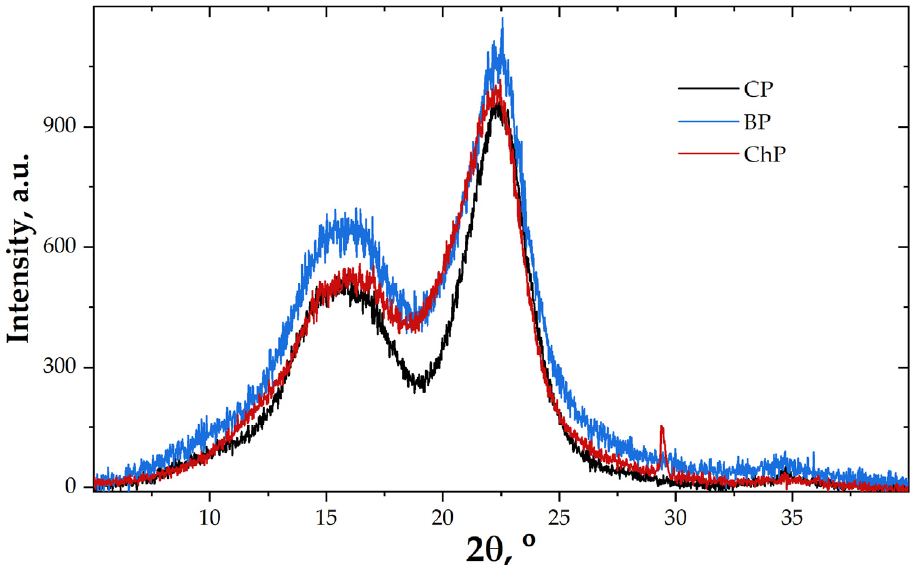
Figure 4. X-ray diffractograms of pine wood samples; CP—contemporary sound pine, BP—biolog-